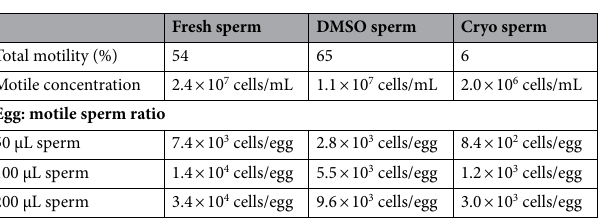
Table 1. Sperm motility and egg:sperm ratios for fresh, DMSO-treated, and cryopreserved sperm in three volumes (50, 100, and 200 µL) used for fertilisation.